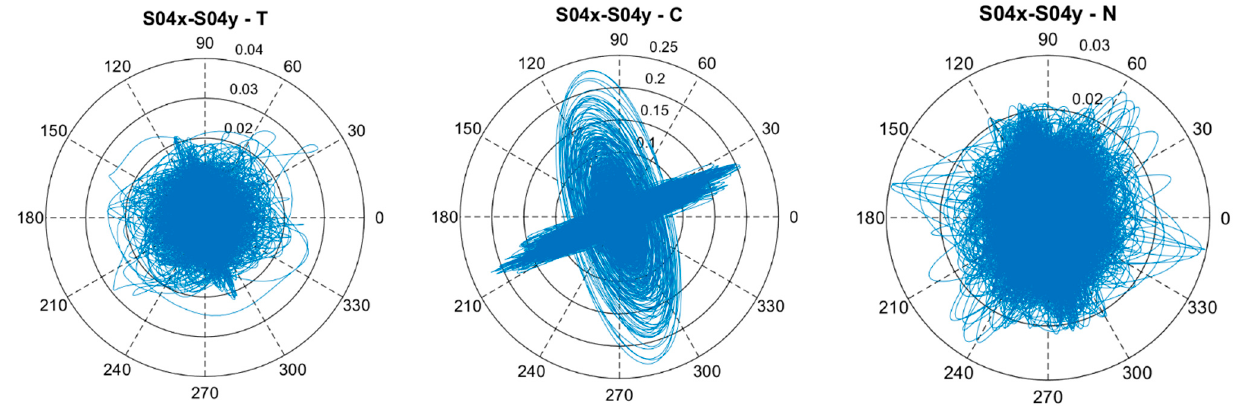
Figure 17. Particle motions at the top of the Torre della Moletta in T, C, and N (amplitude in mm). Figure 18 shows the maximum values of the velocity recorded in the three directions (x, y and z) at the three locations (S02, S03 and S04) of the Torre della Moletta, during the three intervals (T, C, and N). The amplitudes recorded during the concert (C) were